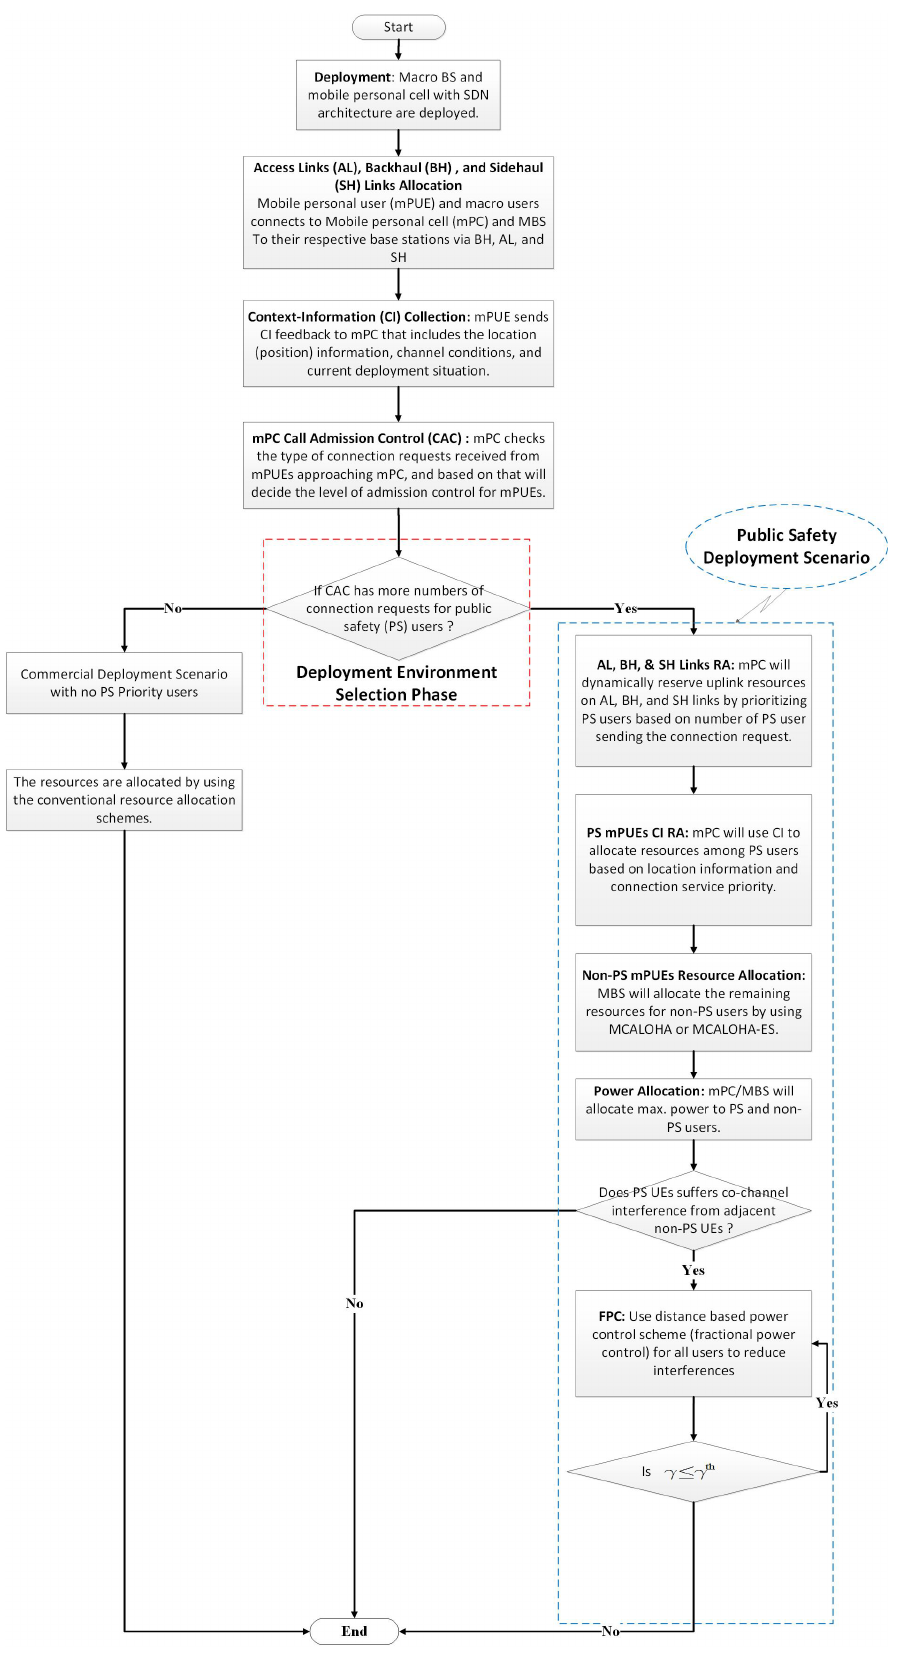
Figure 4. Propose PS-CARA scheme for mPC in public safety